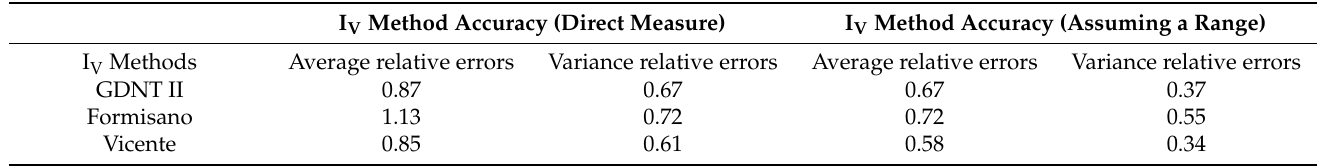
( b ) Figure 13. Relative error distribution of the I V methods obtained from ( a ) the direct measure and ( b ) the full sample range, where in red the reliability of the Vicente method is highlighted.